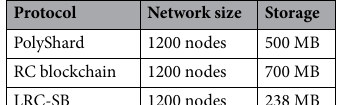
Table 2. Storage required for each node after 5 million transactions have been